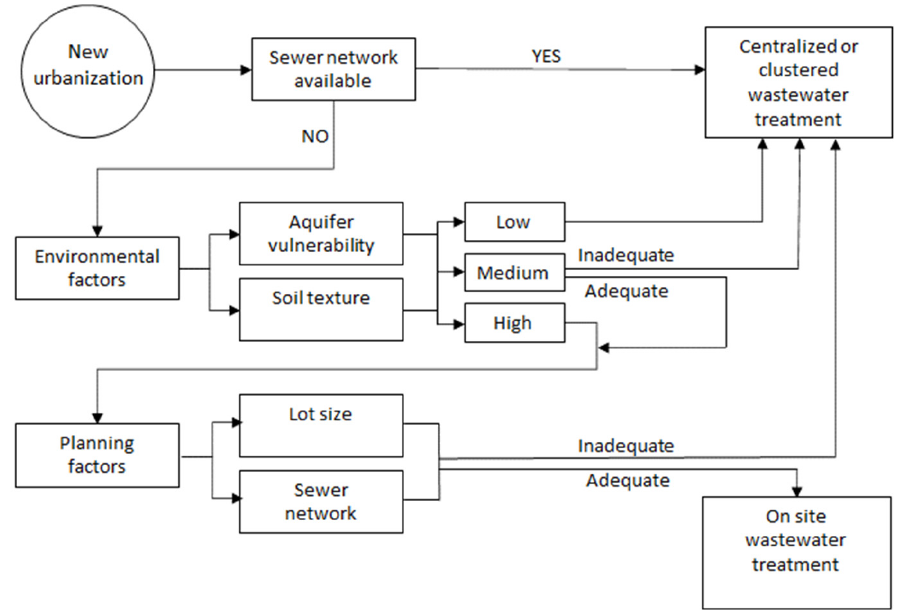
Figure 7 . Flowchart to guide planning decisions based on SDSS . Figure 7. Flowchart to guide planning decisions based on